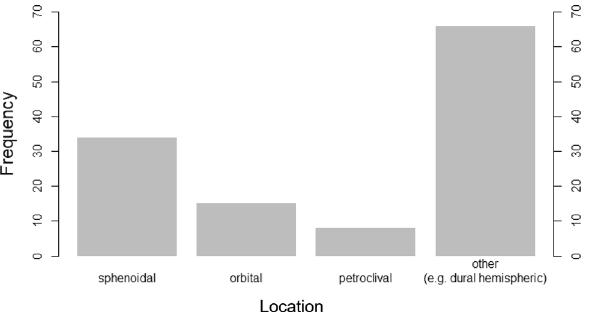
Figure 3. Overview of meningioma location. Frequency of meningiomas in typical locations. The majority of meningiomas were found hemispherical dural. The second most location was sphenoidal. The third most prevalent location was along the N. opticus in the orbit. Petroclival meningiomas were rare.